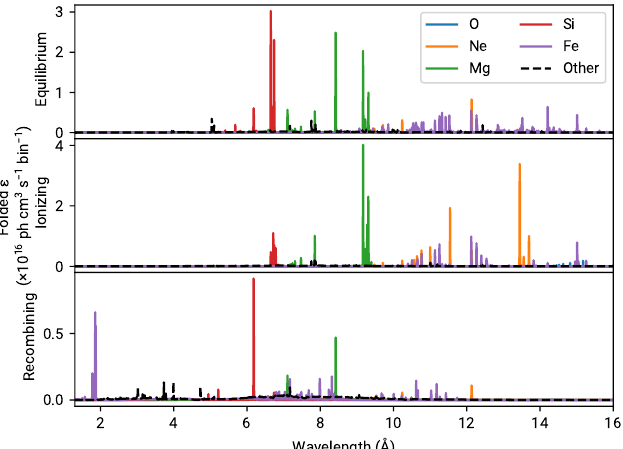
Figure 1. Emission from kT e = 0.7 keV plasmas in equilibrium, ionizing (from kT e = 0.07 keV) and recombining (from kT e = 7.0 keV). The ionization timescale is n e t = 10 10 cm − 3 s for both non-equilibrium cases. Spectra have been folded though the Chandra ACIS-S/HETG +1 order response from Cycle